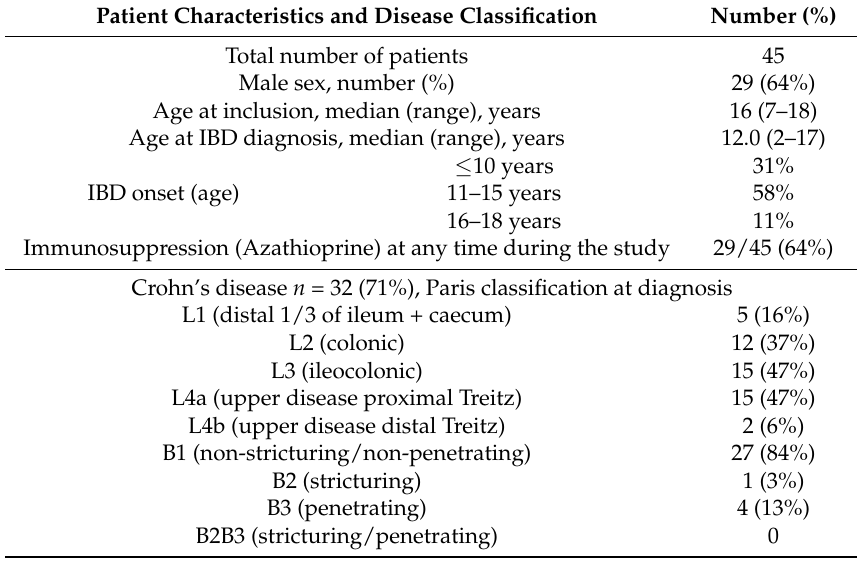
Table 1. Background characteristics of the patient cohort. IBD, inflammatory bowel